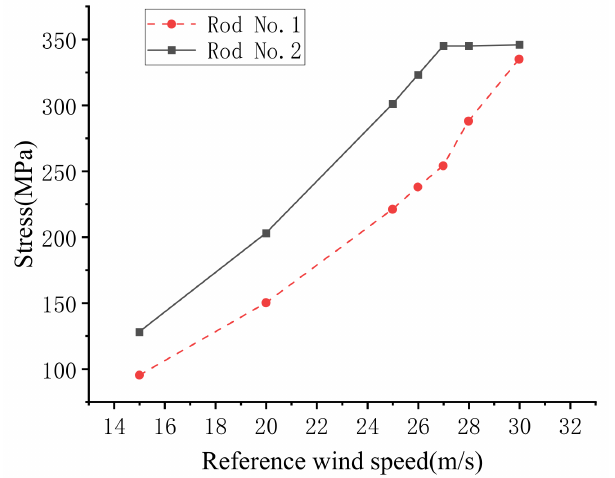
Figure 6. Stress variation curves of No. 1 and No.